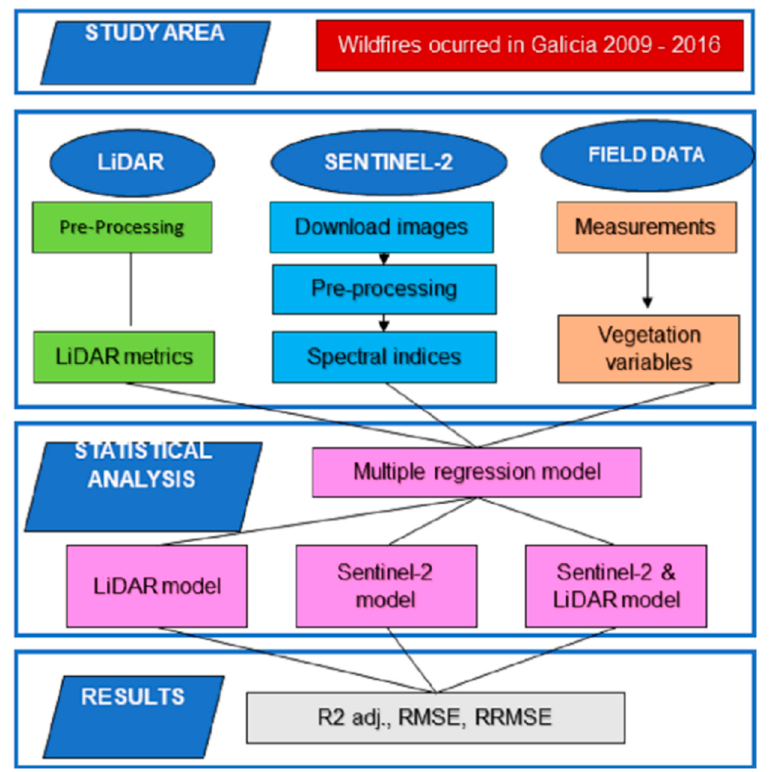
Figure 3. Flowchart of processing steps using LiDAR, Sentinel-2 and field data. Table 2. Sentinel-2 spectral bands.